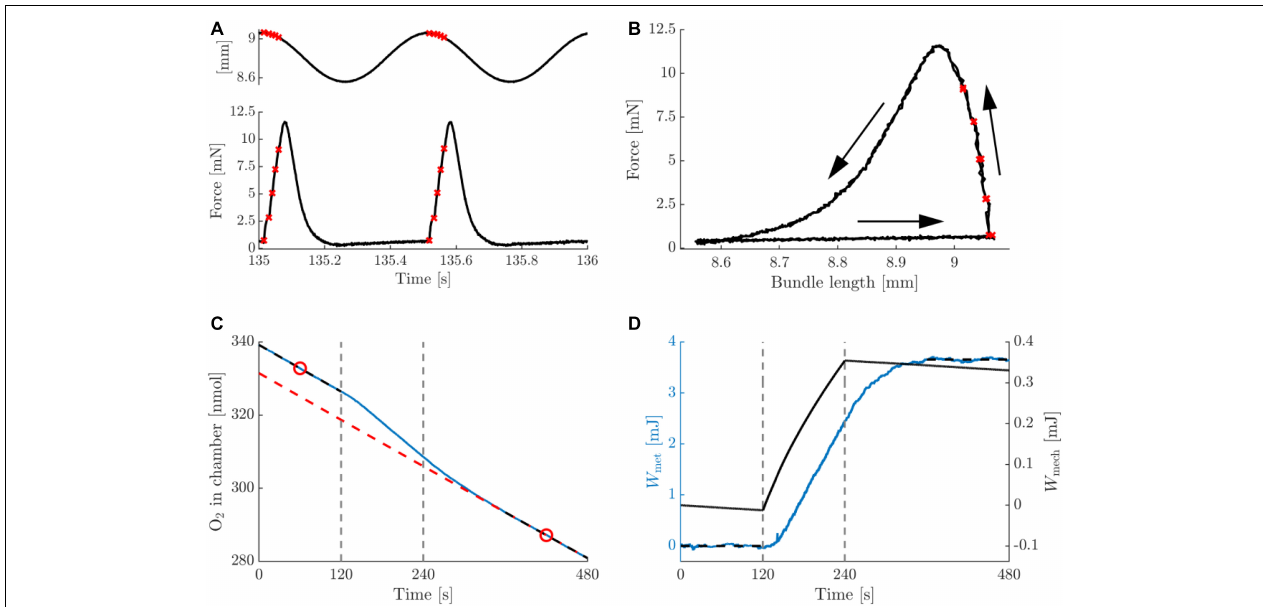
FIGURE 3 | Summary data for a typical example of a concentric trial at a movement frequency of 2 Hz and amplitude 0.25 mm, pre-blebbistatin. (A) Bundle length (top inset) and force against time, relative to the onset of the trial. (B) Work loop depiction (force against bundle length) of the data in panel (A) , the two cycles are superimposed. Arrows indicate the progression of time. The red crosses in panels (A,B) indicate instances at which stimuli were delivered. (C) Total amount of oxygen present in the chamber (blue, solid line), and the baseline oxygen trace of the chamber + bundle resting consumption (red, dashed line), against time. The black, dashed line sections are linear fits to the first and last 2 min of the oxygen trace, and the red circles are the means of these fits. The baseline is a 2nd degree polynomial of which the slope at the time points given by the red circles is equal to the slope of the respective black dashed lines, and which passes through the rightmost red circle. Vertical dashed lines indicate the start and end of the stimulation period. (D) left (blue) axis: net (baseline subtracted) oxygen consumption of bundle expressed as caloric equivalent, against time. The net amount of energy liberated by the bundle during the trial was computed as the difference between the mean of the first and last 2 min of the trial (horizontal black, dashed lines). Right (black) axis: total mechanical work computed as the integral of force with respect to bundle length change, against time. The net mechanical work associated with the trial was computed as the difference between the values at the beginning and the end of the stimulation period (vertical, dashed lines). Note that the work calculated directly from panel (B) would yield a net negative value per cycle, as per convention the force from the muscle on the environment is depicted positive, whereas in the calculation of mechanical work it was taken to be